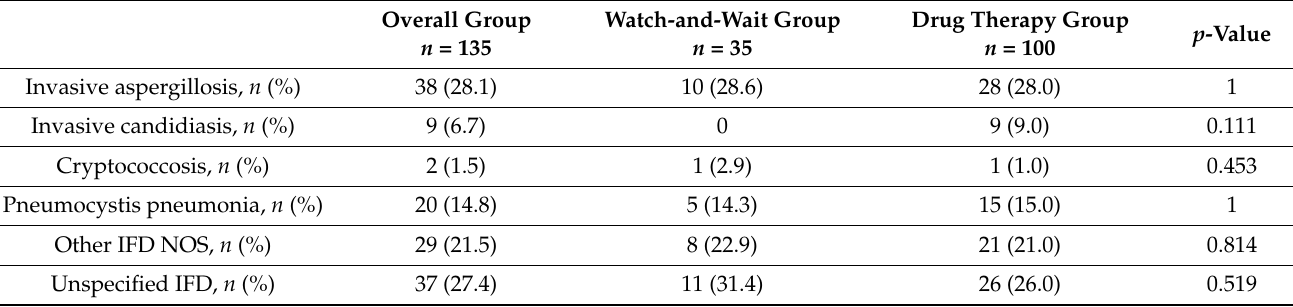
Table 2. Characteristics of invasive fungal